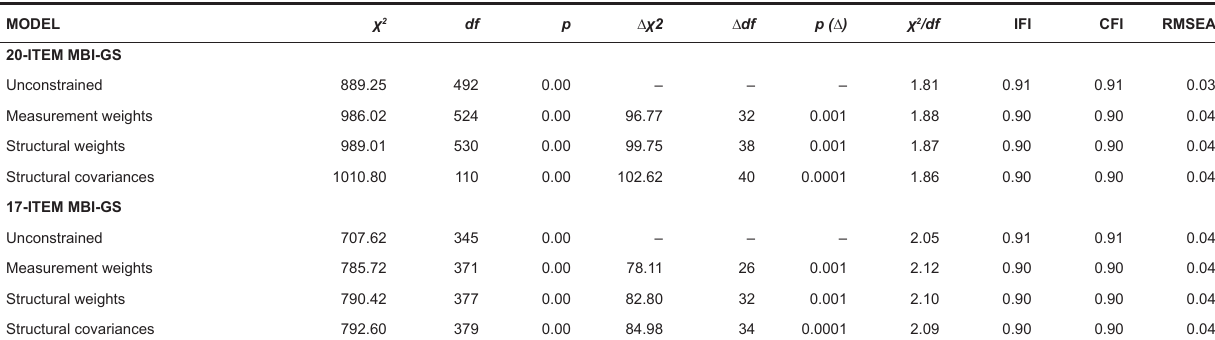
TABLE 3 Testing for measurement invariance of the adapted and translated